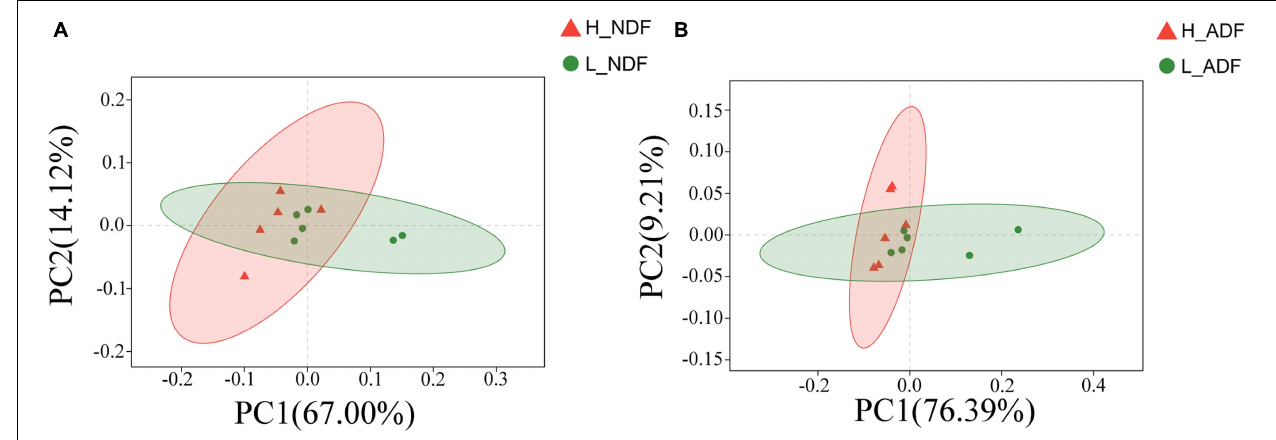
FIGURE 4 | The principal coordinates analysis (PCoA) of CAZyme gene between high and low apparent fiber digestibility. PCoA plot show the significant difference in CAZyme gene diversity between H_NDF and L_NDF groups ( A , P = 0.044), and H_ADF and L_ADF groups ( B , P = 0.020).